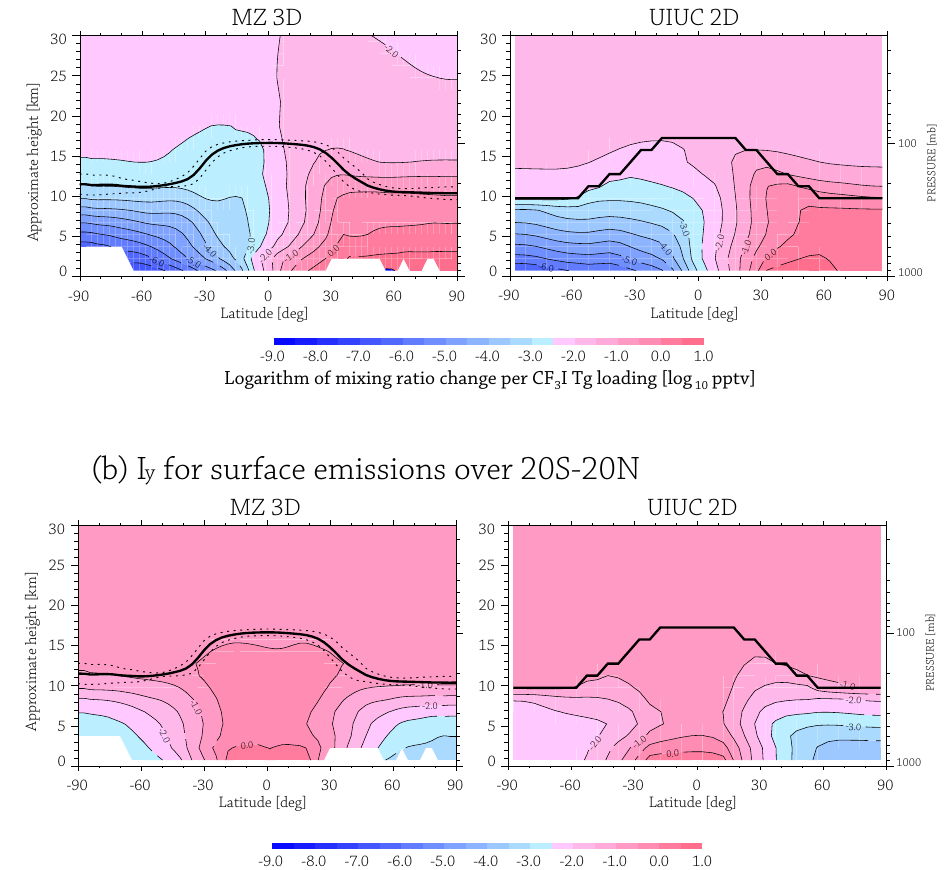
Fig. 6. Logarithm of annually averaged I y mixing ratio changes per CF 3 I Tg loading for (a) mid-latitude and (b) tropical emission